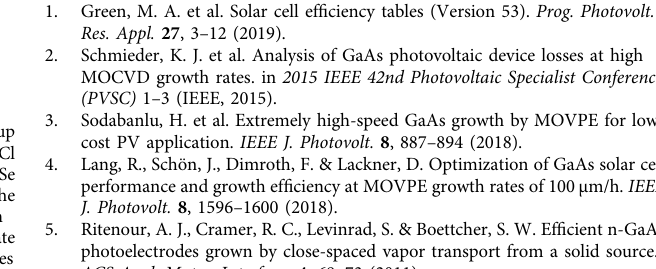
Fig. 1a. The sources used in our D-HVPE system are AsH 3 and PH 3 for the group V sources, and GaCl and InCl, which are formed in situ by fl owing anhydrous HCl over Ga and In metal, as the group III sources. The dopants are Zn (p-type) and Se (n-type) supplied as diethylzinc and H 2 Se, respectively. The source zone where the metal chlorides are formed is held at 800 °C, while the deposition zone (growth temperature, T G ) is held at 650 °C for all materials grown in this work. Growth rate studies were conducted by growing lattice-matched GaAs/GaInP/GaAs structures on (100) GaAs substrates miscut 4° towards (111)B. Epilayer thickness